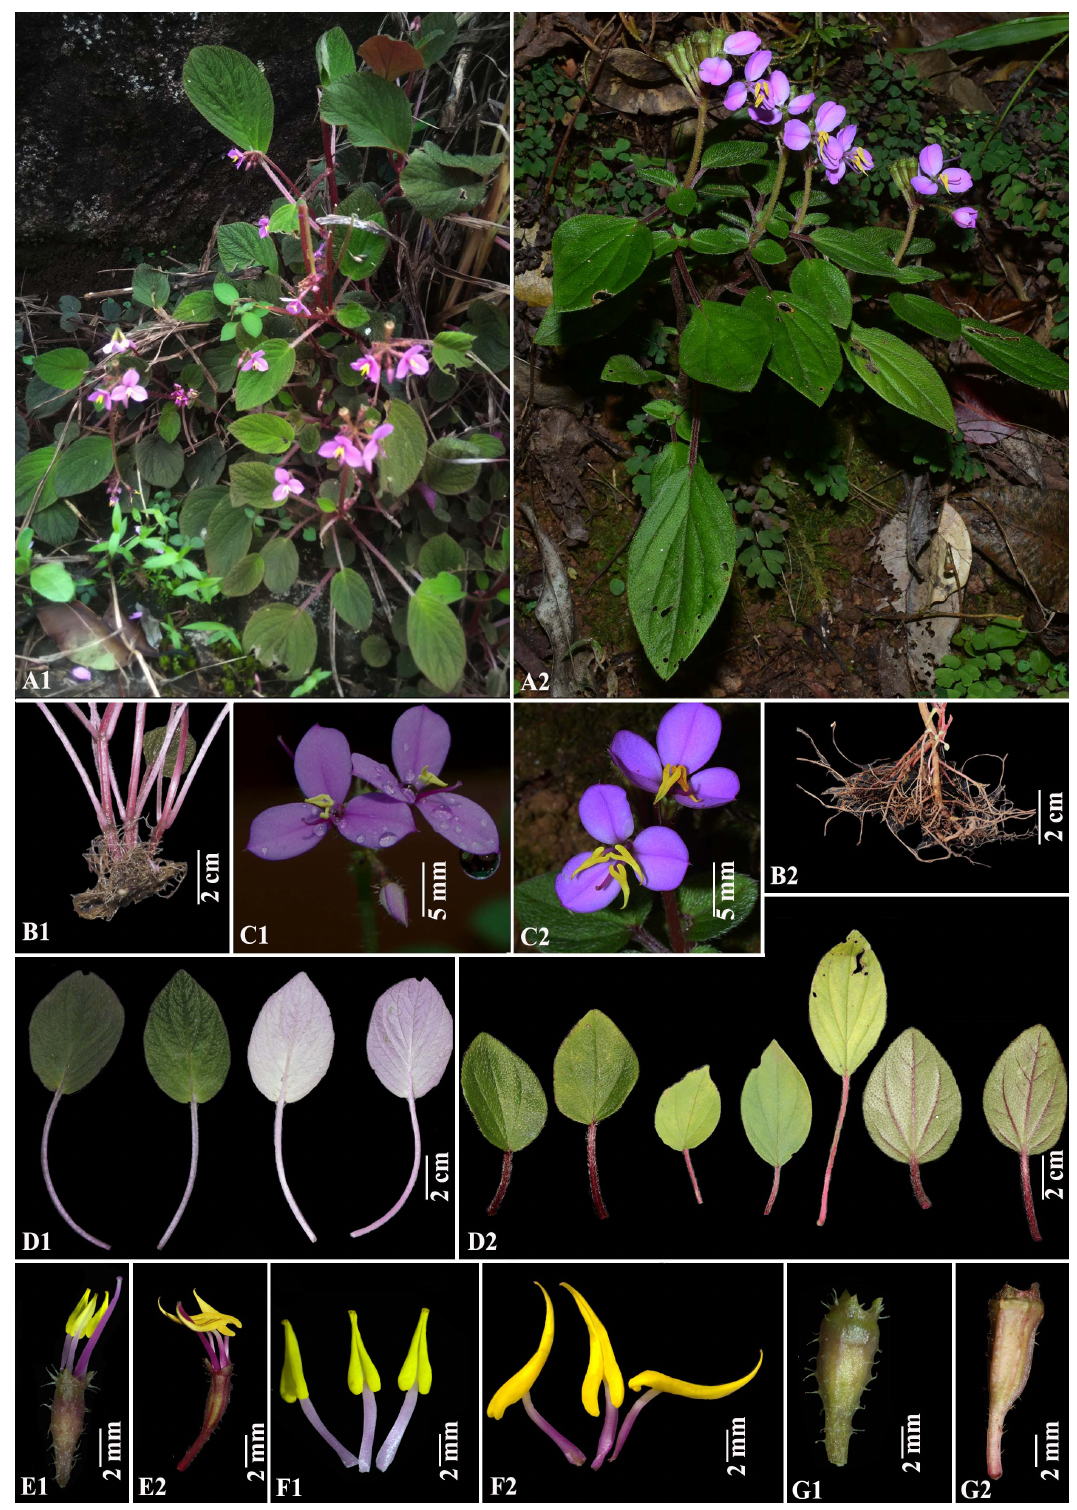
Fig. 4. Comparison between Sonerila longipedunculata Resmi & Nampy sp. nov. (A1–G1) and S. travancorica Bedd. (A2–G2). A . Habit. B . Root stock. C . Flowers. D . Leaves, adaxial and abaxial views. E . Hypanthium with stamens and pistil. F . Stamens. G . Capsule. A1–G1 based on Resmi & Santhosh Nampy 151222 ; A2–G2 based on Resmi S. & Santhosh Nampy 151284